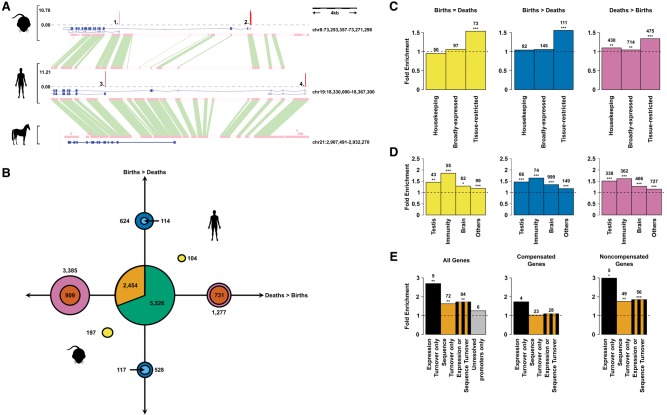
Compensatory promoter turnover and positive selection. (A) Human, mouse, and horse alignments at the PDE4C locus. Four promoters are shown, which are conserved (promoters 1 and 3), human-deleted (promoter 2), or mouse-deleted (promoter 4). Gene models supported by the CAGE promoters are shown in the blue boxes, where solid boxes represent coding exons and empty boxes noncoding exons. The histograms in red describe the log2-transformed expression level of the annotated promoters. Orthologous sequence identified between species is highlighted by the green boxes between these sequences. (B) Frequencies of 1:1 orthologous genes in human and mouse categorized by the type of promoter sequence turnover events. The blue circles represent genes with a greater proportion of promoter births than deaths, while the purple circles similarly represent genes with a greater proportion of promoter deaths. Genes with an equal number of promoter births and deaths are shown in the yellow circles. All genes are shown in the outer circles, while the numbers in the inner circles shows those with evidence for compensatory promoter turnovers. Genes with only expression turnover at their promoters are shown in the orange segment, while the remainder of the green circle indicates the number of genes with a conserved promoter architecture (C,D). Enrichments of human orthologous genes with different turnover events and expression profiles relative to genes with a conserved promoter architecture. χ2 test, (*) P < 0.05, (**) P < 0.01, (***) P < 0.001. (E) Enrichments of orthologous genes with coding sequence positive selection. Genes are classified by the possible different evolutionary outcomes of their associated promoters relative to genes with a conserved promoter architecture. χ2 test, (*) P < 0.05, (**) P < 0.01, (***) P < 0.001.